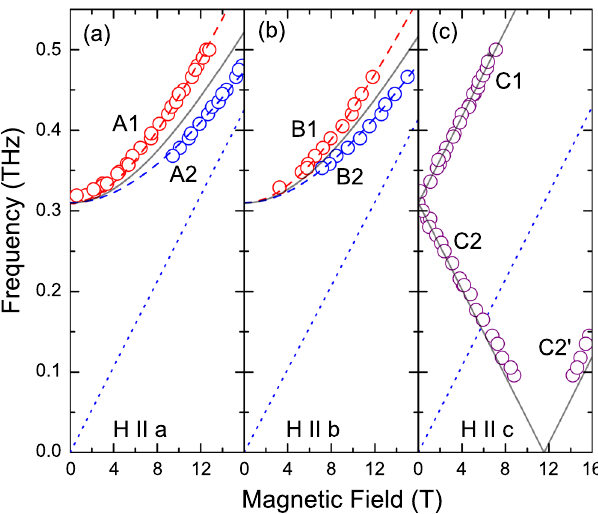
Fig. 2 | Frequency- fi eld diagrams of magnetic excitations in CROC. Fields are applied along the a ( a ), b ( b ), and c ( c ) axis ( T =2K). The solid lines are results of calculationsusingEqs.(3)and(4).Thedottedlinescorrespondtotheparamagnetic g -factors, 1.88, 1.85, and 1.92 for fi eld applied along the a , b , and c axis, respectively 19 . The dashed lines are guides for the